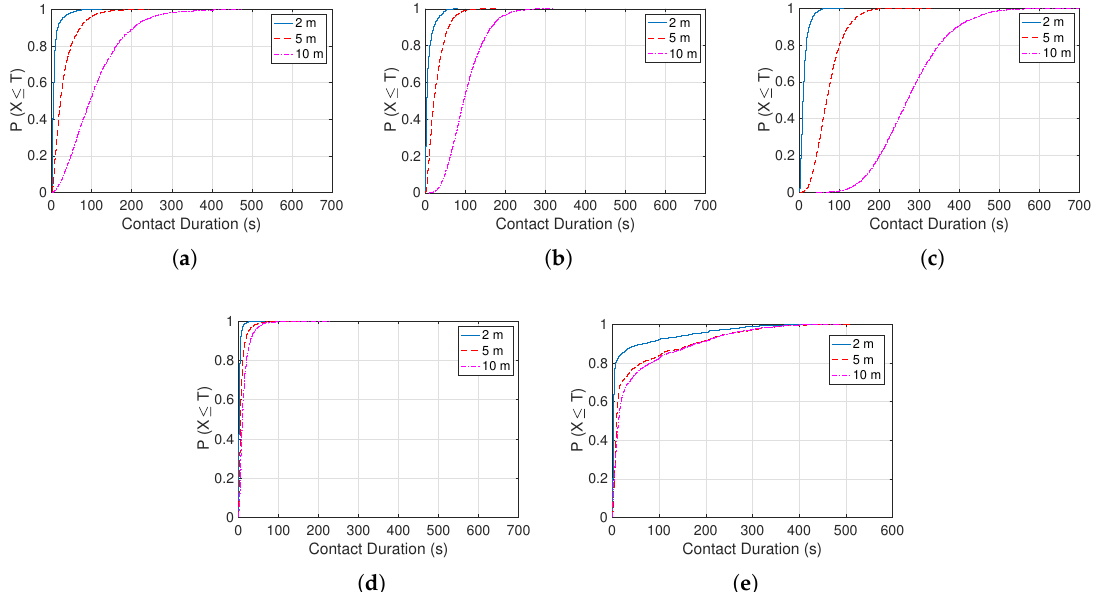
Figure 6. CDF of the contact durations for different distances in the following scenarios: ( a ) RWP; ( b ) SWIM; ( c ) RWPa; ( d ) Plaza; ( e )